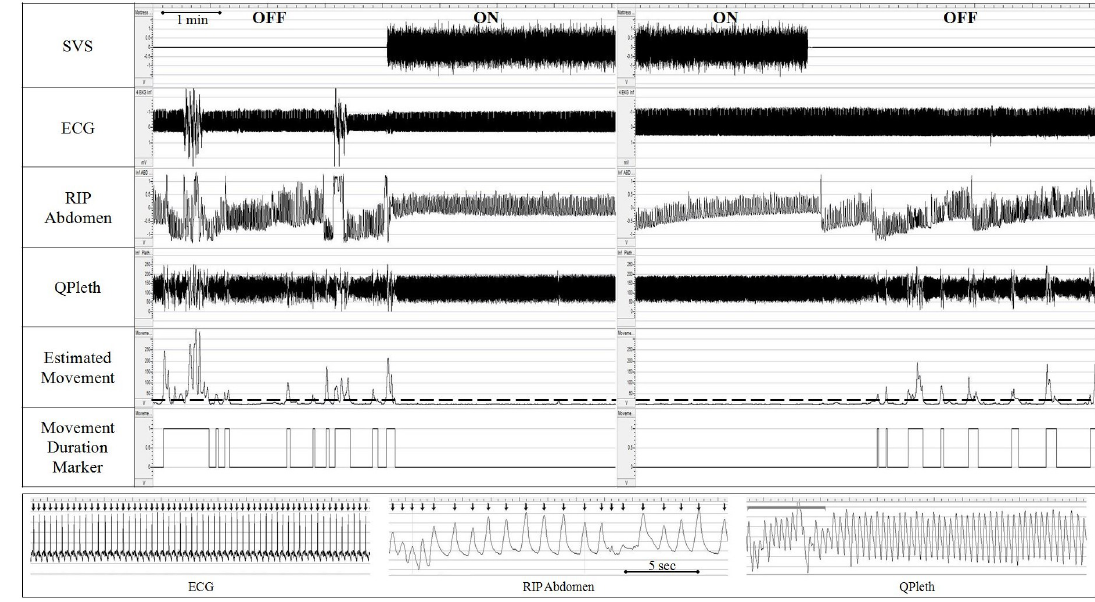
Fig 2. Physiological response to SVS. Upper panel: Improved cardio-respiratory stability and reducedmovement with stimulation.Lower panel: Expanded view: 1) ECG: Arrows indicateheart rate calculatedfrom cardiacR-waves; 2) RIP Abdomen: Respiratory inductanceplethysmography; Arrows indicate respiratoryrate determinedfrom inspiratorypeak; 3) QPleth: Gray line indicatesdistortion from movement activity.